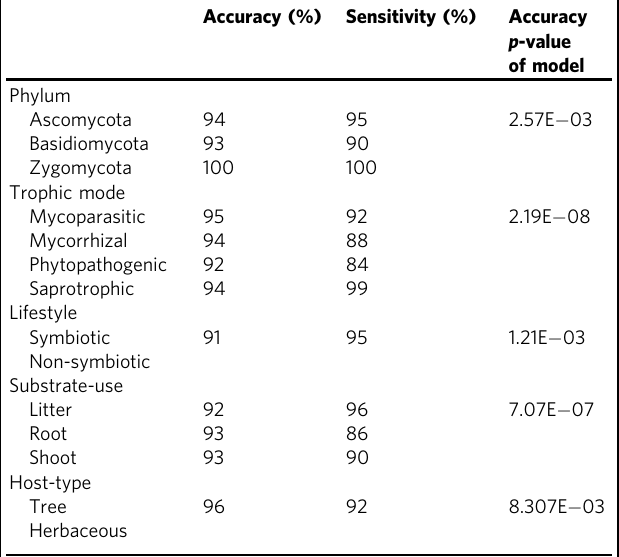
Accuracy, sensitivityand model p -valueare given asthe mean of the three predictivemodels on PTR-ToF-MS and GC – MS